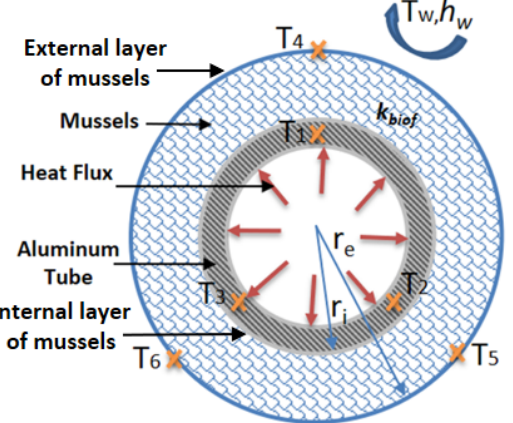
Figure 7. Middle cross-section of the aluminum tube with uniform mussels colonization.